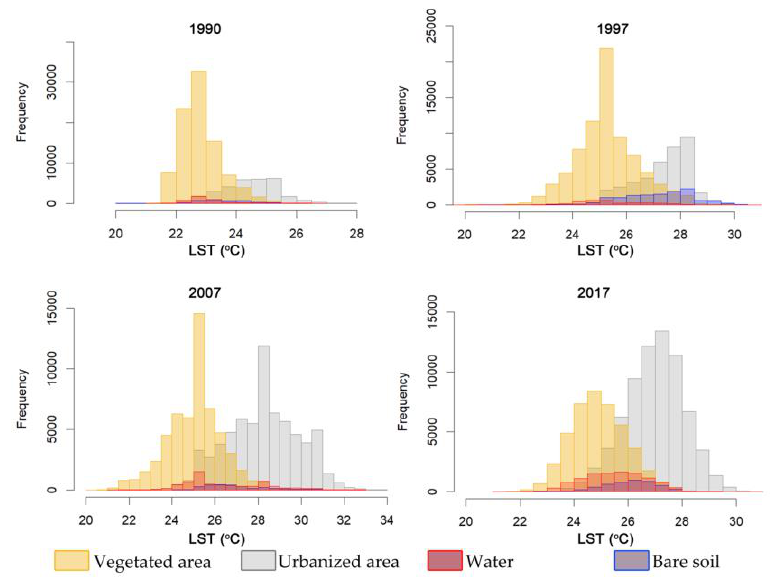
Figure 10. Histogram of LST for LCZ cluster.